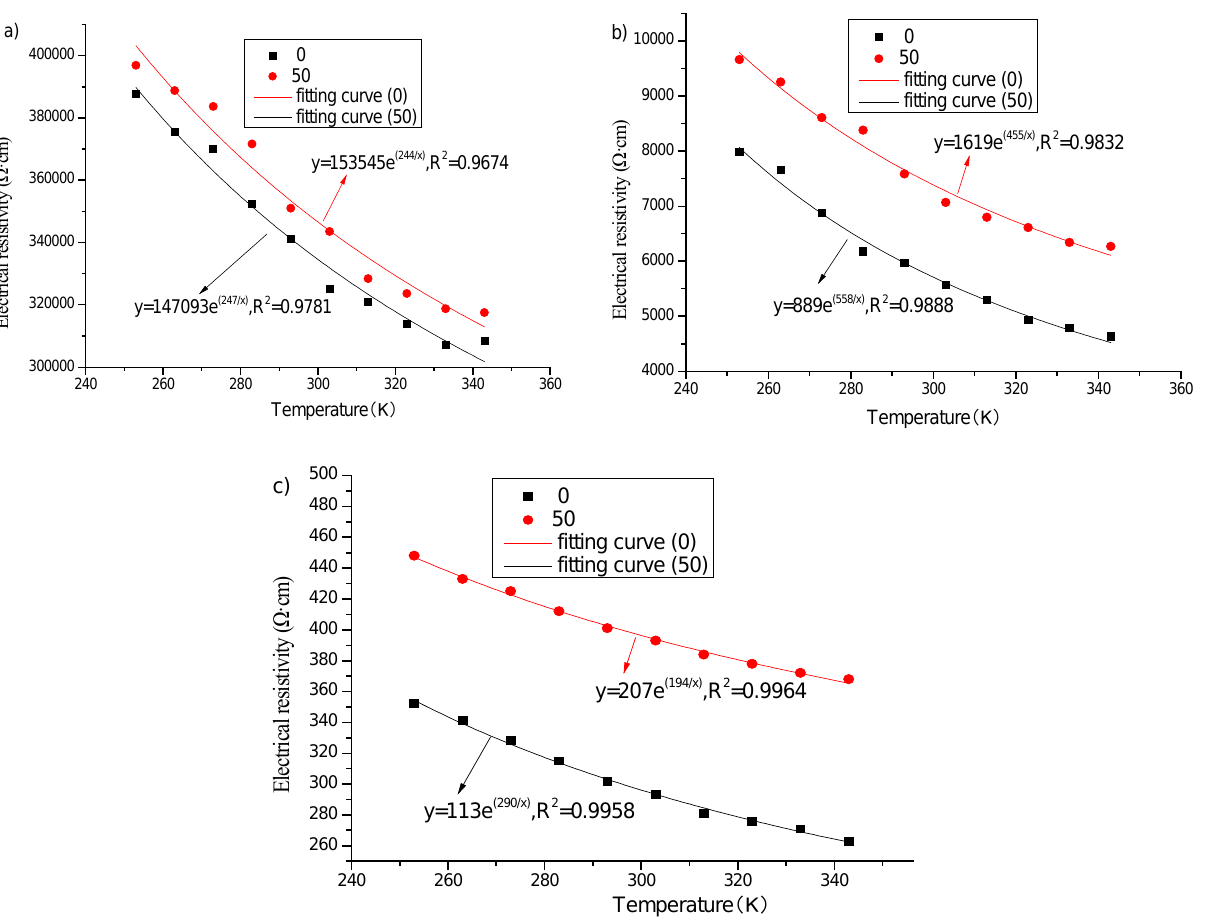
Figure 15. Fitting of electrical resistivity of specimens with different graphene contents before and after freeze–thaw: ( a ) 1%; ( b ) 2%; ( c ) 3%. Table 9. Fitted results of electrical resistivity of specimens incorporating different graphene con- tents before and after freeze–thaw.